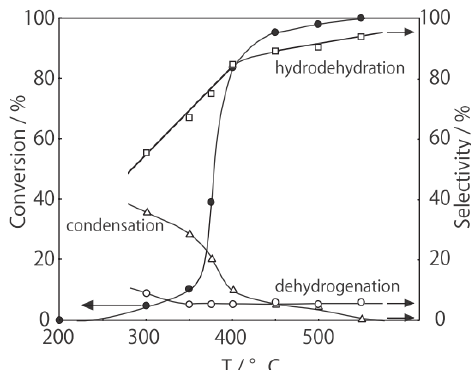
Figure 6. Effect of temperature on reactivity and selectivity in the catalysis